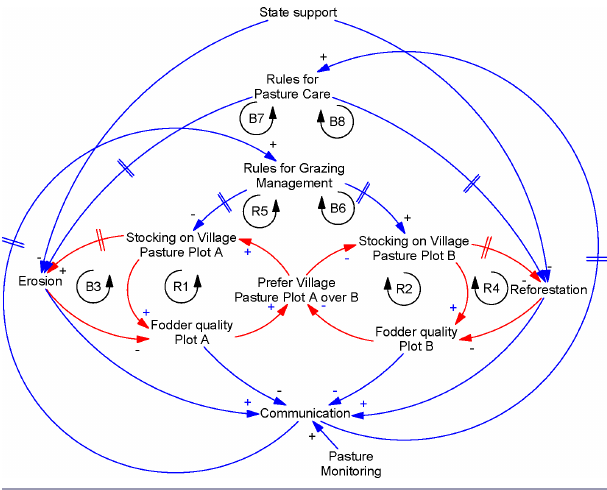
Fig. 8 . The Success to the Successful archetype applied to simultaneously occurring overuse and underuse of pasture plots (red) and solution by designing rules for pasture management and care (blue).